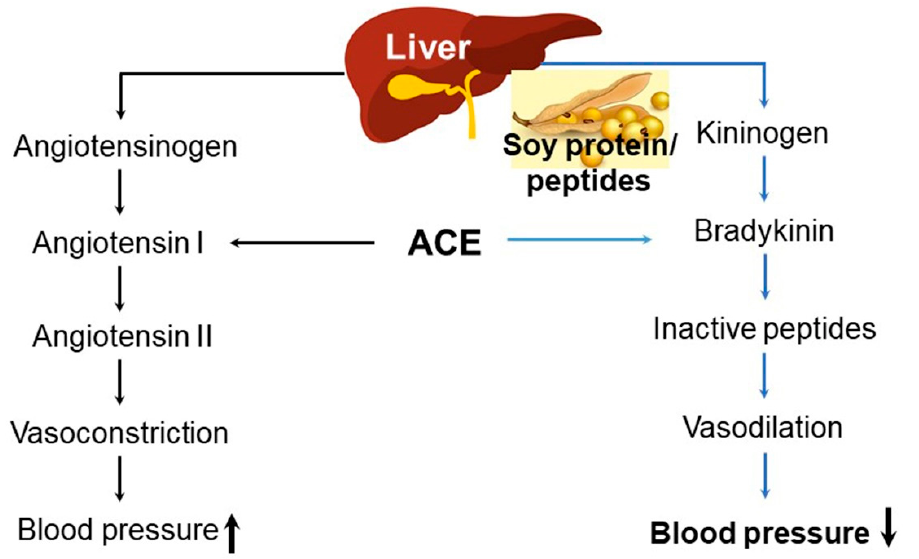
Figure 13. Regulation of angiotensin-converting enzyme (ACE) in blood pressure by soybean protein. ACE catalyzes the degradation of bradykinin, a blood lowering-protein/peptide in the kallikrein–kinin system. Inhibition of ACE is postulated to be an effective medical target in the treatment of hypertension. Hypertension is a key factor associated with several diseases, such as cardiovascular disease and stroke [5]. Figure adapted from Chatterjee, C. et al. [5]. Table 2. Potential bioactive peptides derived from soybean and its by-products [5,134]. Peptide Sequences